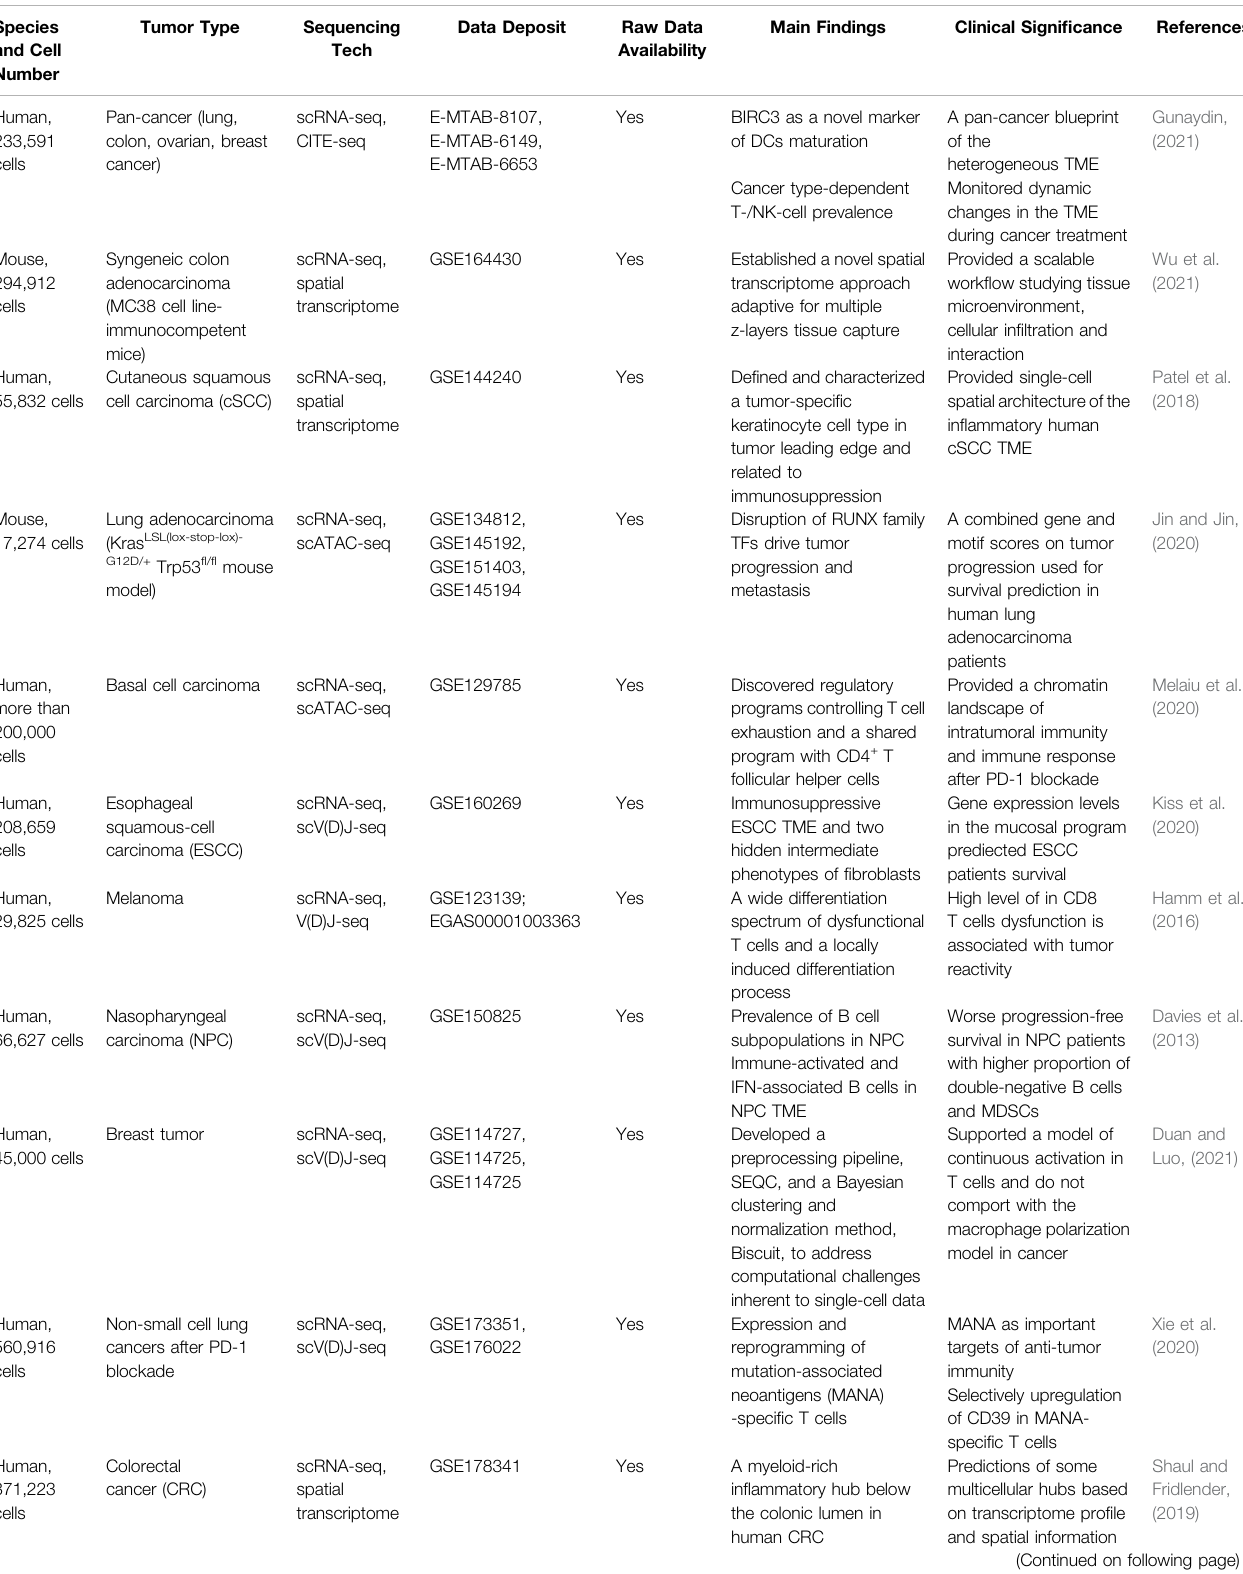
TABLE 1 | Recent publicly available single-cell datasets of TME. Species and